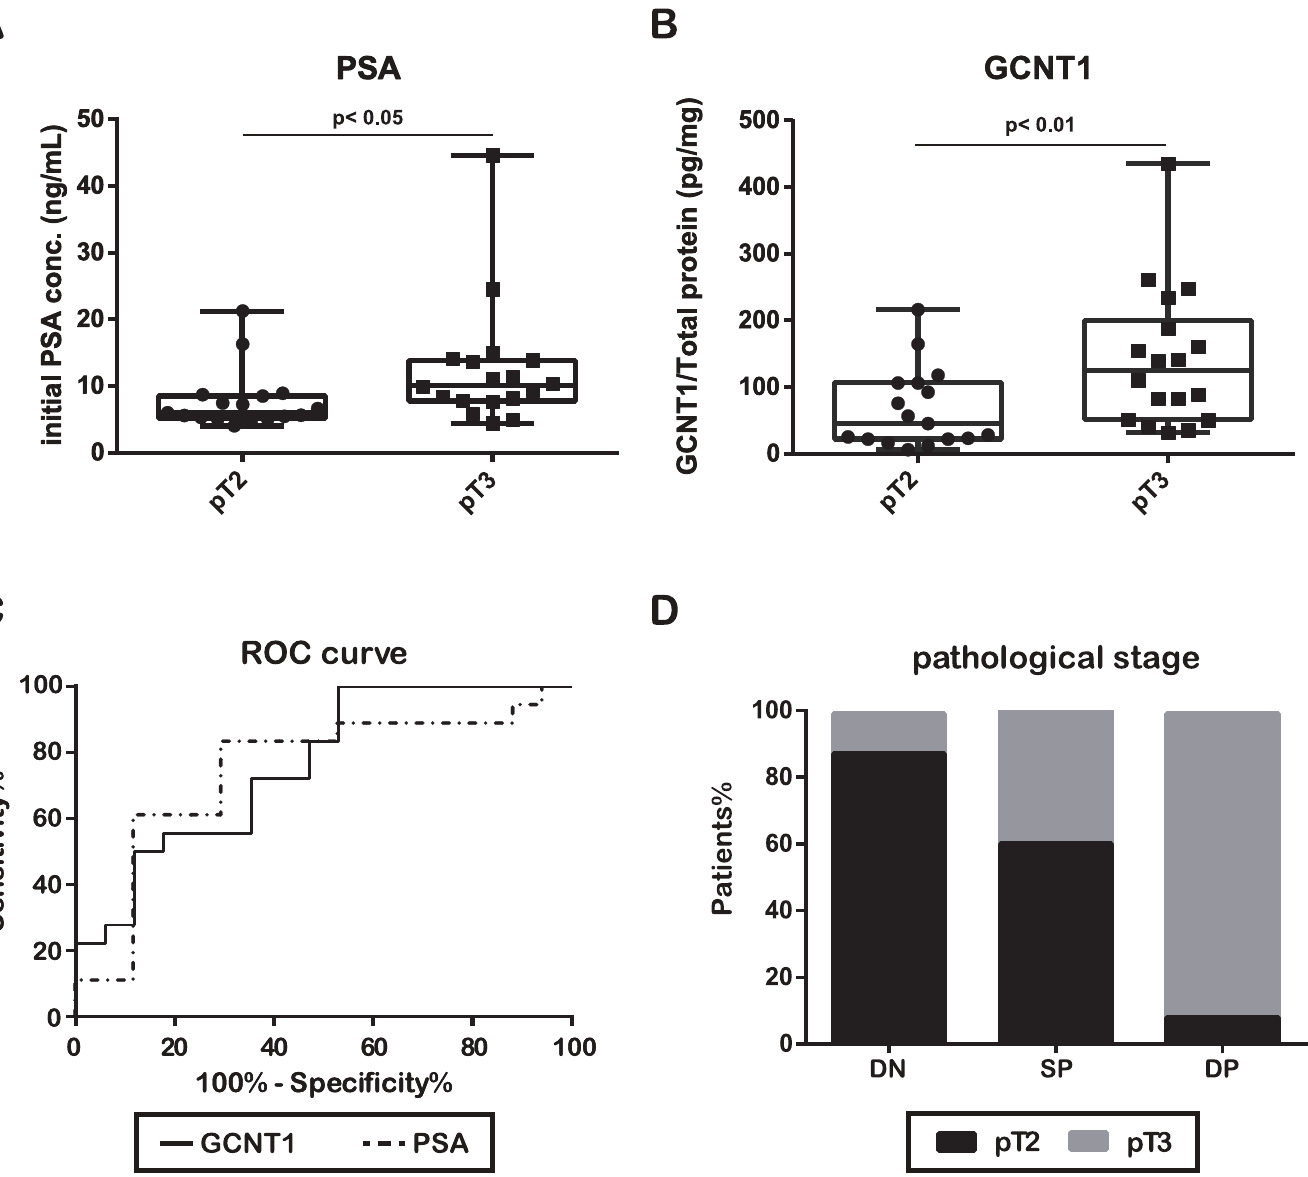
Fig 3. Prostate-specific antigen concentration and core2 β -1,6- N -acetylglucosaminyltransferase-1 expression predict extracapsular extension of prostate cancer. ( A ) Prostate-specific antigen (PSA) concentration and ( B ) Core2 β -1,6- N -acetylglucosaminyltransferase-1 (GCNT1) expression levels were significantly higher in prostate cancer (PCa) patients with extracapsular extension than in patients with organ-confined disease. ( C ) Receiver-operator characteristic curve analysis of PSA and GCNT1 revealed that the area under the curve of PSA was 0.7455 and GCNT1 was 0.7614. ( D ) Risk stratification was established using PSA and GCNT1 to predict the outcome of local PCa. Double negative (DN)-risk (PSA < 7.52 ng/mL, GCNT1 < 79.36 pg/mg), single positive (SP)-risk (PSA > 7.52 ng/mL or GCNT1 > 79.36 pg/mg) and double positive (DP)-risk (PSA > 7.52 ng/mL and GCNT1 > 79.36 pg/mg) patients are